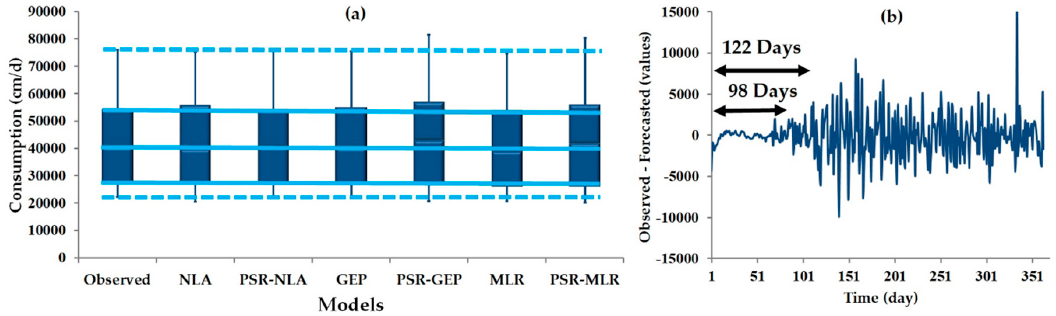
Figure 8. Performance of the models ( a ) box-plot of forecasted values in comparison with observed values; ( b ) Residual of PSR-NLA (best performance) in two forecasting horizons.